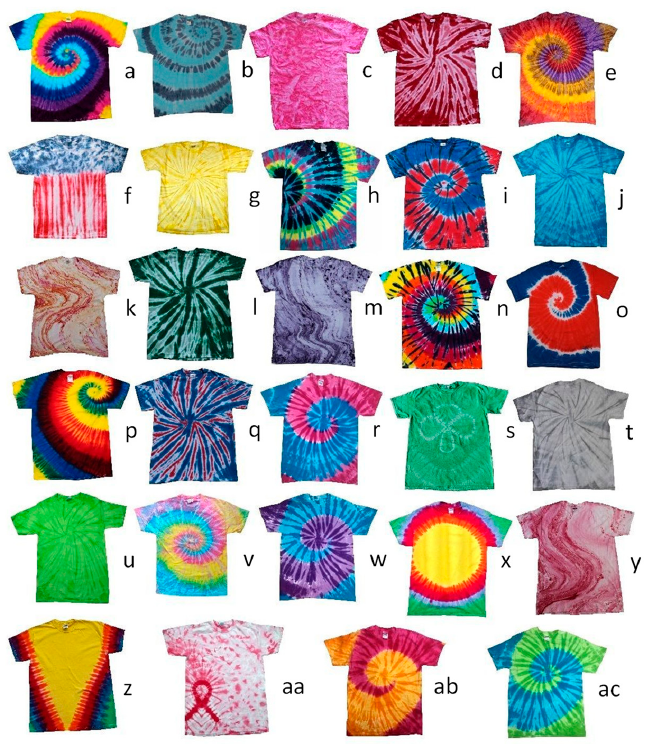
Figure 2. Twenty-nine dyed T-shirt images ( a – ac ) are shown for color analysis demonstration.